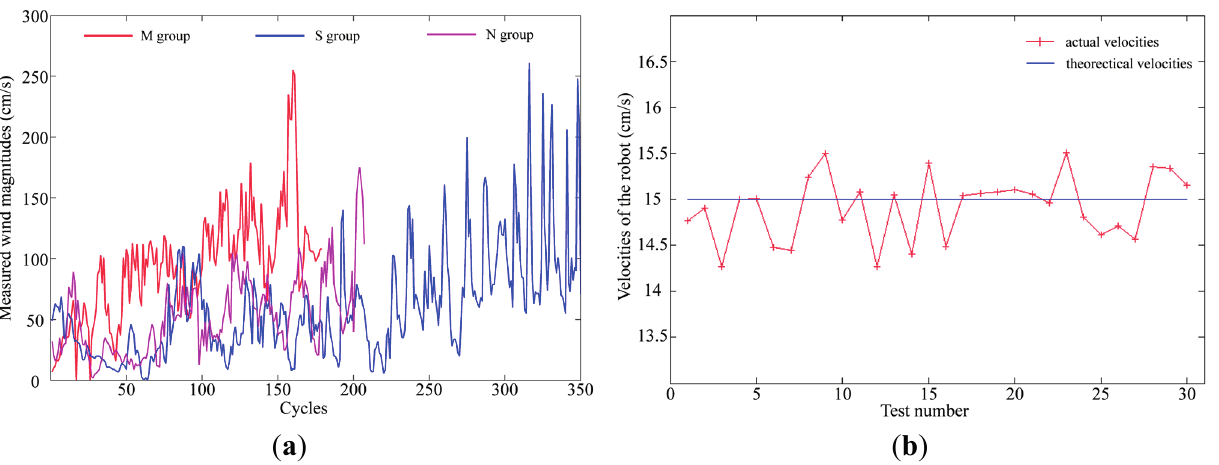
Figure 16. ( a ) Typical wind magnitudes measured in the three groups of experiments; ( b ) The robot’s actual velocities recorded in 30